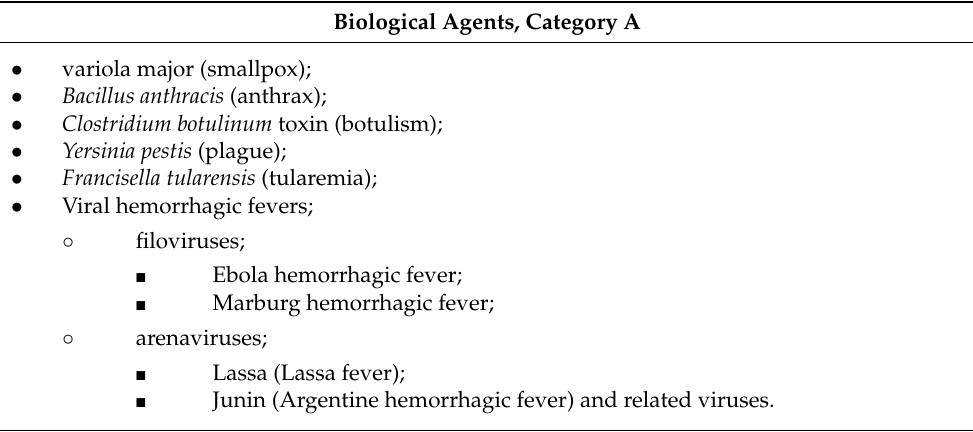
Table 9. Biological agents category A, B, and C, CDC classification